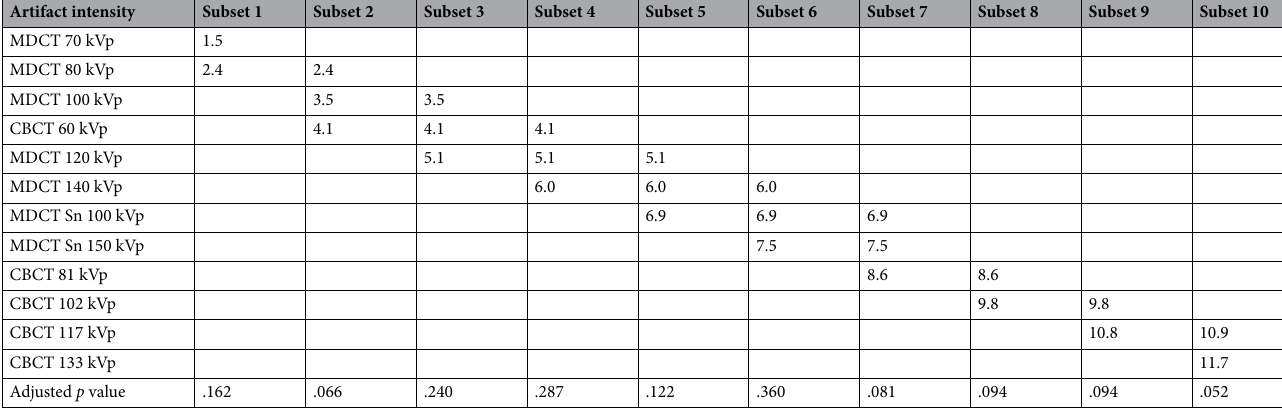
Table 5. Homogeneous subset analysis for image artifact intensity based on tube voltage groups. After differences between dependent nonparametric variables were ascertained with the Friedman test ( p < .001), groups were compared pairwise with post-hoc tests and listed in order of ascending mean rank. The rank means that are listed under each subset are not significantly different from each other. In contrast, mean values that are not listed in the same subset differ significantly (adjusted p value for multiple comparisons <